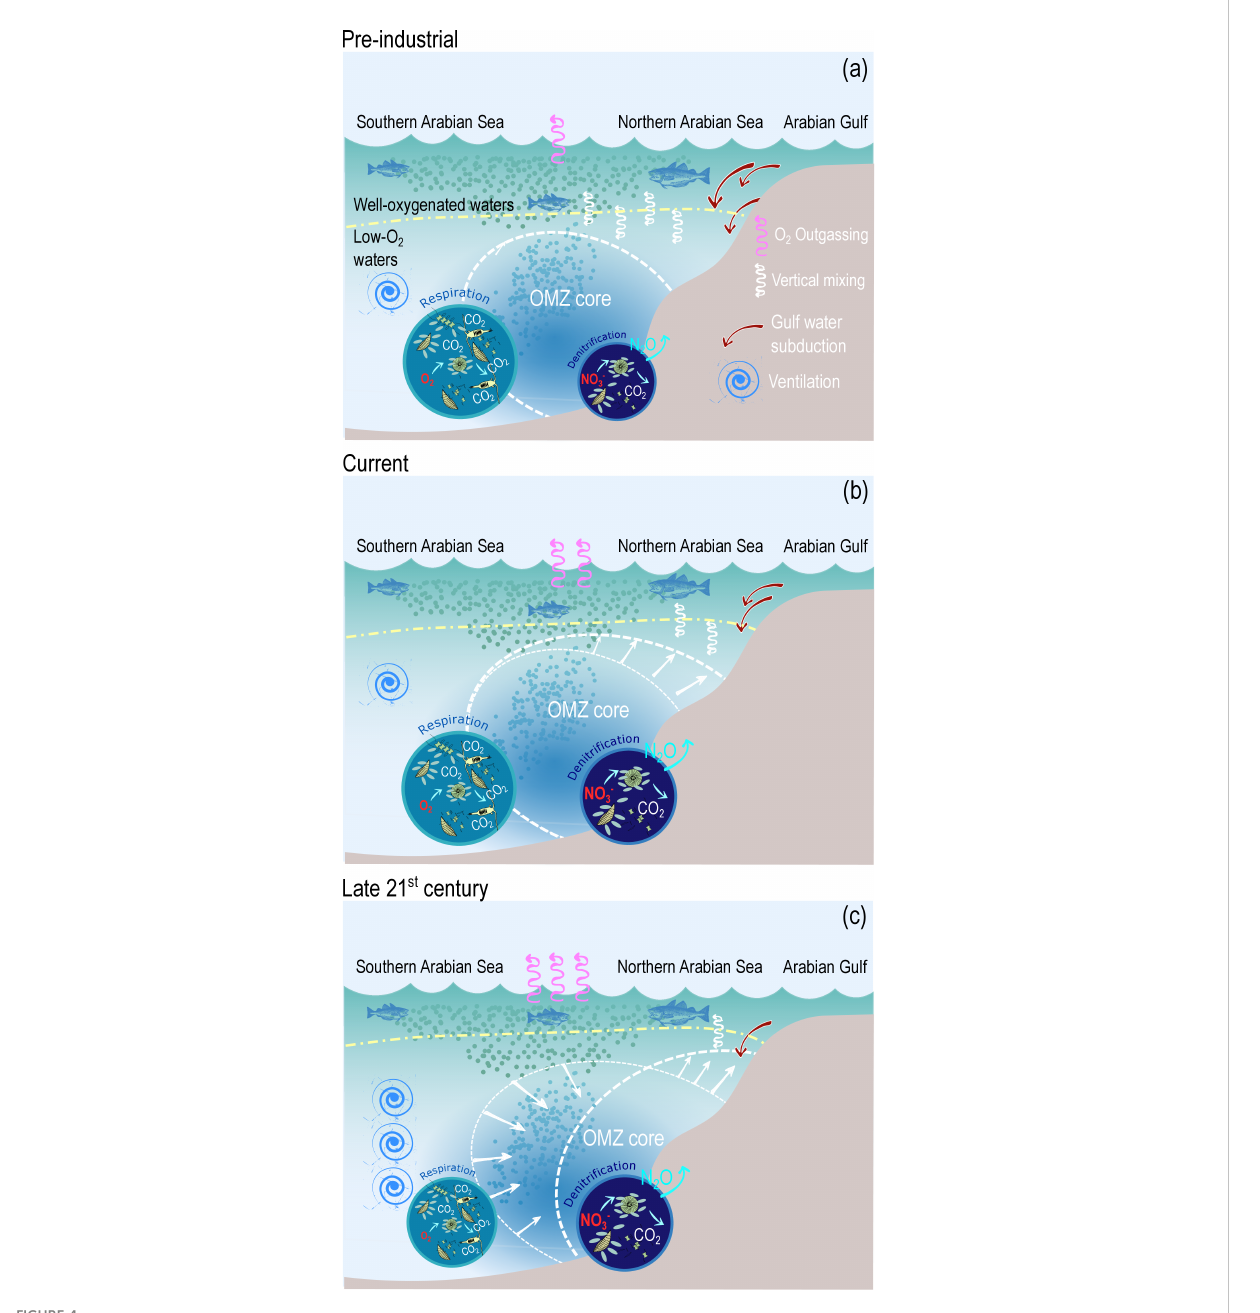
FIGURE 4 Summary of recent and potential future changes in Arabian Sea OMZ. This schematic summarizes the recent and main potential future changes in the Arabian Sea OMZ as well as their drivers and implications. (A) Pre-industrial conditions: cool conditions favor strong O 2 solubility in the seawater and weak outgassing. Well-oxygenated waters (O 2 > 100 mmol m -3 ) occupy a thick upper layer overlaying the OMZ. Strong winter convection and subduction of Gulf waters in the north ventilate the upper OMZ, thus maintaining its denitrifying suboxic core contained at depth. (B) Present-day conditions: weaker O 2 solubility in the seawater causes moderate outgassing. A weaker winter convection and subduction of Gulf waters in the north cause an expansion of the upper OMZ and an increase of denitri fi cation. (C) Future conditions: warmer conditions further lower O 2 solubility in the water and enhance outgassing. Moreover, enhanced strati fi cation limits the vertical penetration of well-oxygenated waters, contained in a thinner layer (compressing potential habitat). Reduction in winter convection and Gulf water subduction causes a weakening of the ventilation of the upper OMZ in the northern Arabian Sea and a shoaling of the OMZ core, potentially leading to enhanced denitri fi cation there. However, in the central and southern Arabian Sea, enhanced ventilation as well as reduced productivity and respiration lead to important oxygenation at depth, causing a substantial shrinking of the OMZ